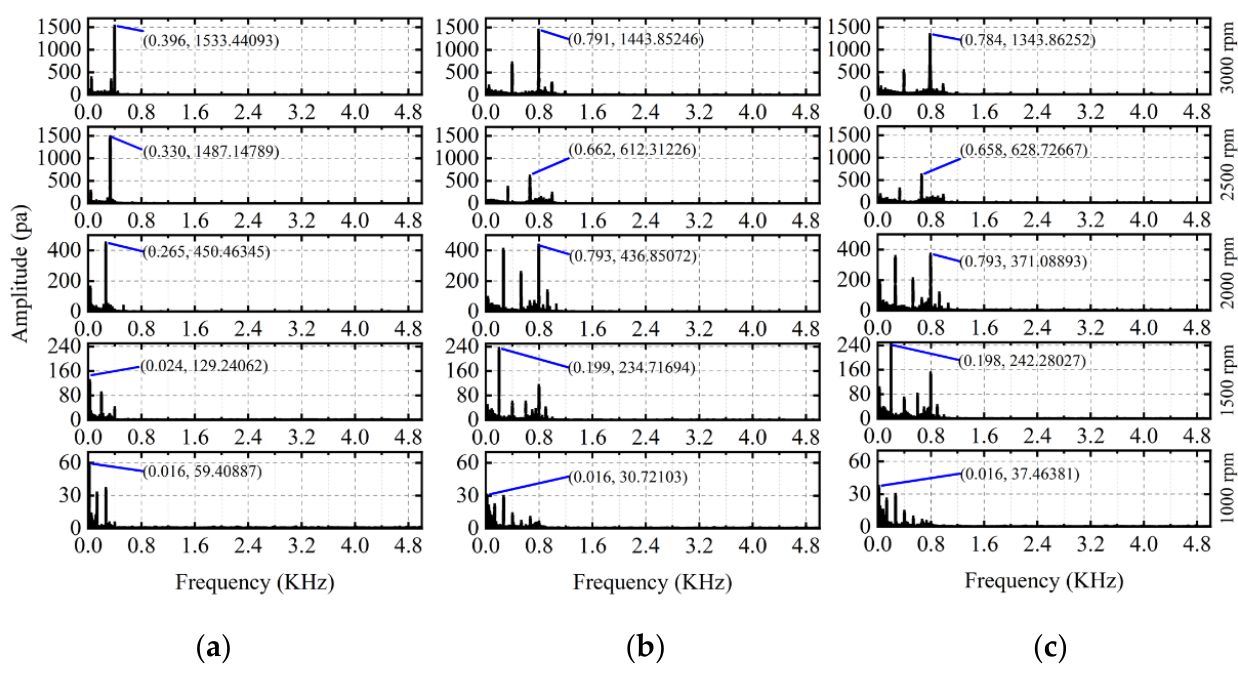
Figure 11. Frequency domain of pressure pulsation for three volutes at different impeller speeds. ( a ) Single-tongue volute; ( b ) double-tongue volute (static); ( c ) double-tongue volute (rotate).